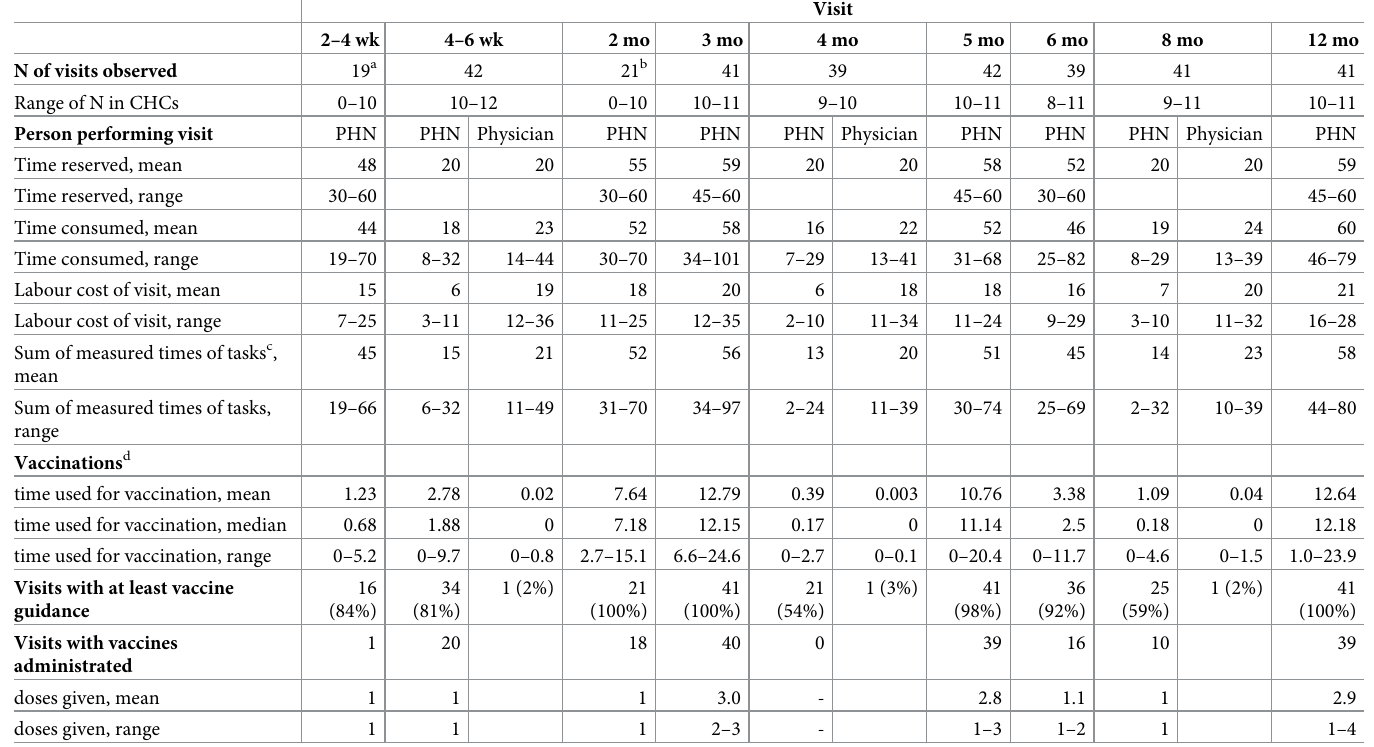
Table 3. Time used and cost of the visits observed. Time used for vaccinations during all